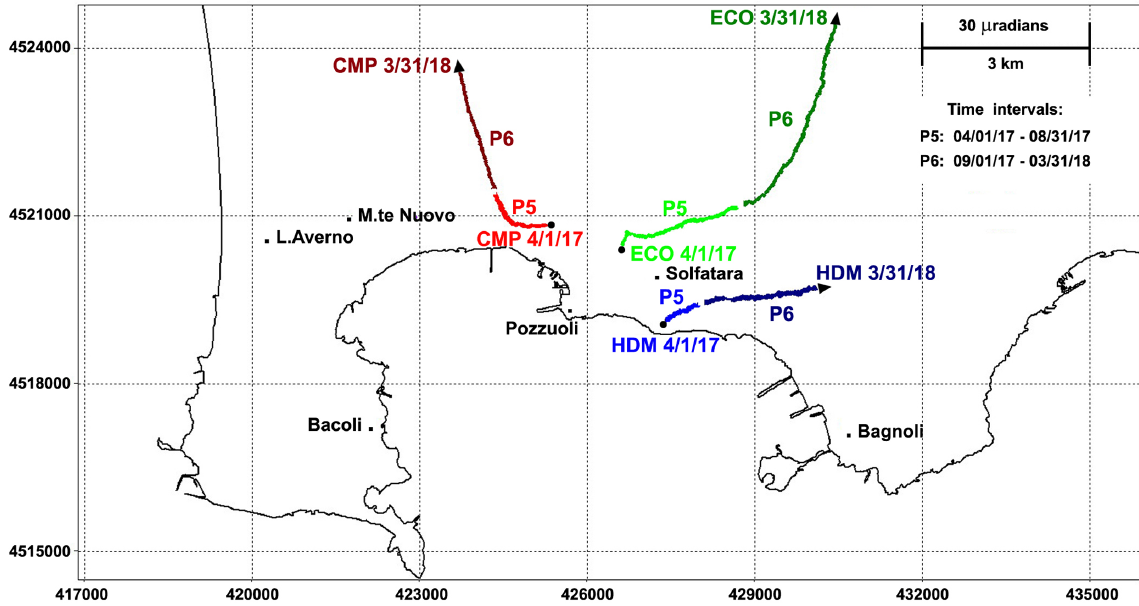
Figure 5. Plots of the tilt vectors at the three sites CMP, ECO and HDM. The curves that originate from each station indicates the cumulative tilt variation (hodograph) recorded in P5=1 April 2017–31 August 2017 (light color) and P6 = 1 September 2017–31 March 2018 (dark color). Each mesh is equivalent to a tilt variation of 30µradians. The boundary between the two intervals P5 and P6 is marked with a white